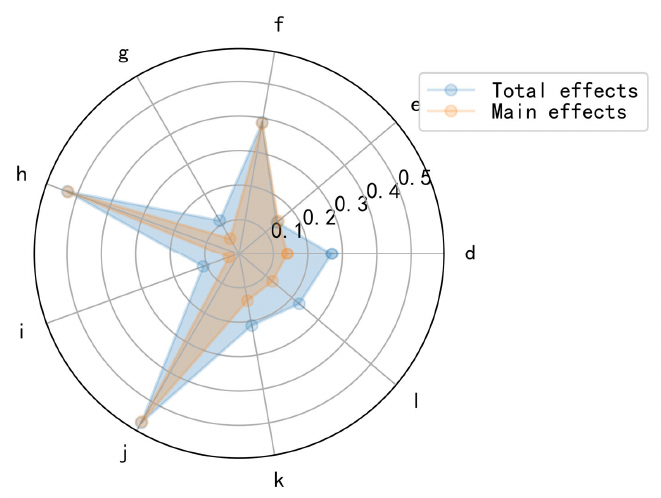
Figure 9. The main e ff ects and total e ff ects of each in fl uencing factor of RV reducer rotation error.